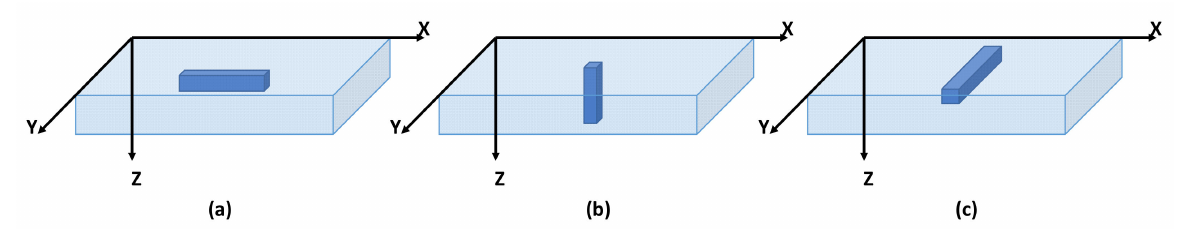
Figure 2. Orientation of compression samples in the printing manufacturing domain: ( a ) X, ( b ) Z and ( c )